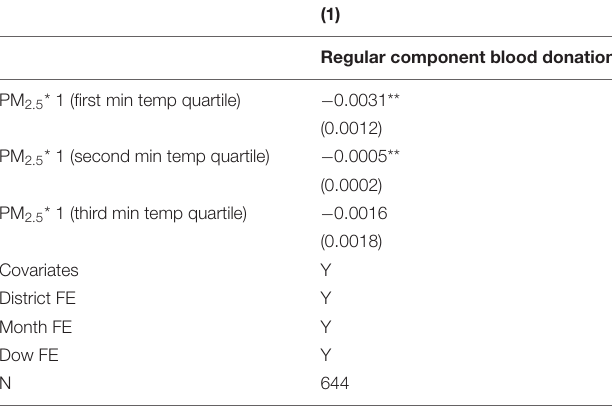
TABLE 9 | Moderating role of daily minimum